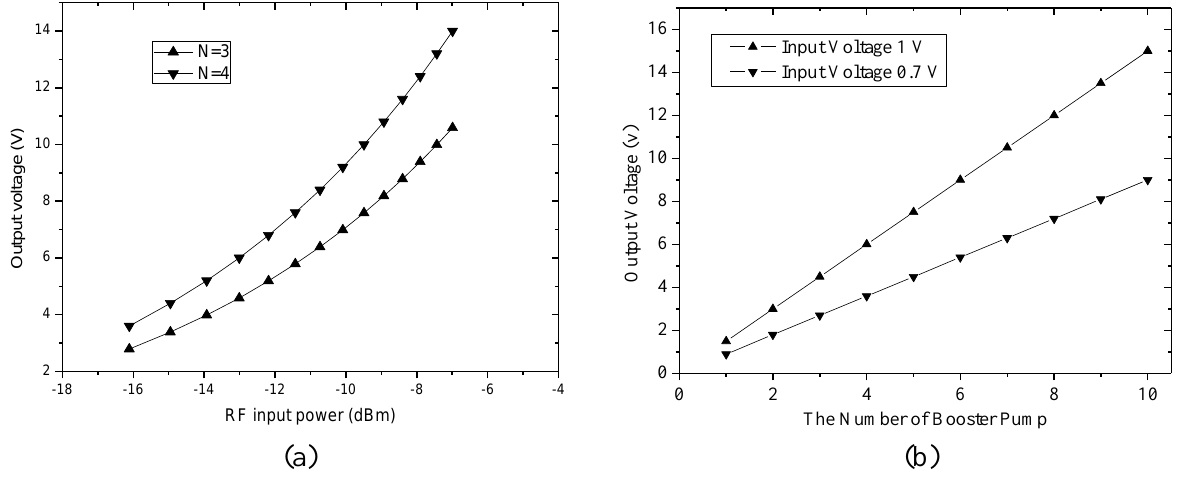
Figure 3. Output voltage curves of the charge pump rectifier (a) Output voltage with different input power (b) Output voltage with different number of charge pump stage.